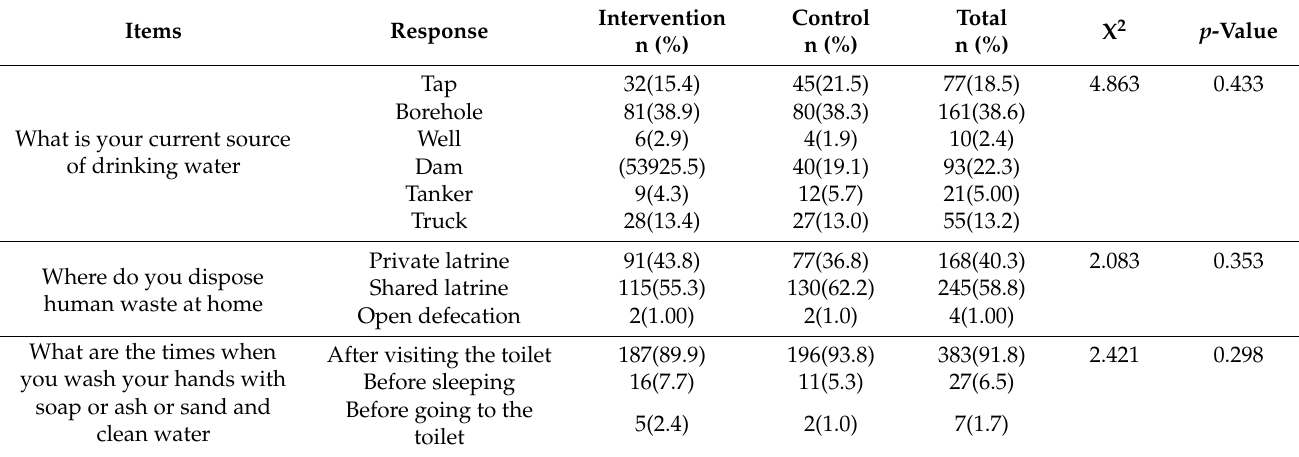
Table 1. WASH practice of respondents at